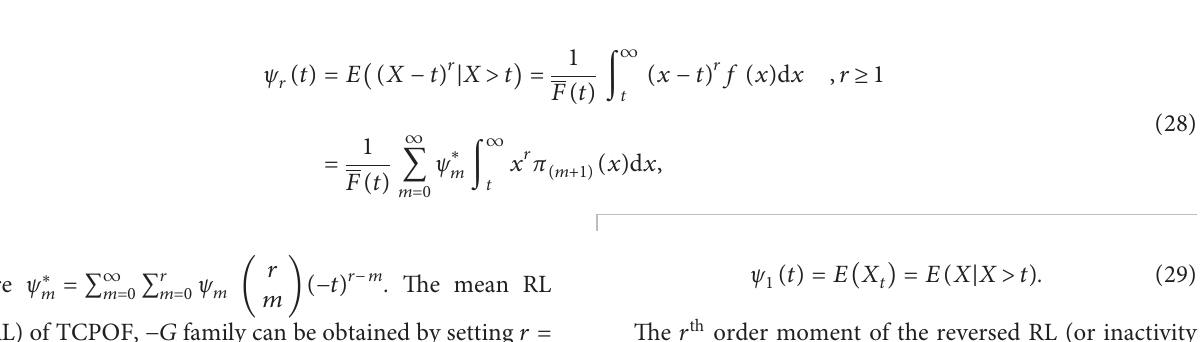
Figure 1: TCPOFW, TCPOFE, TCPOFR, and TCPOFL densities for different values of